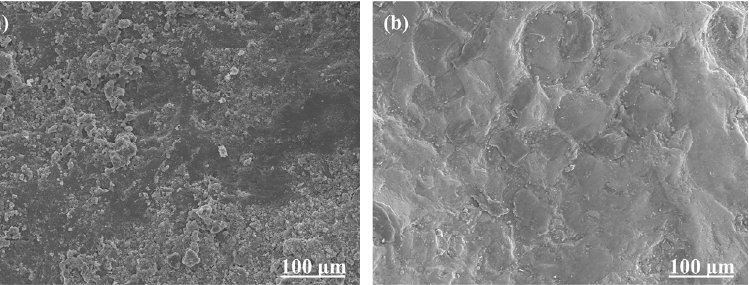
Figure 5. ( a , b ) are the SEM images of the steel slag before and after 7 polishing cycles, respectively.